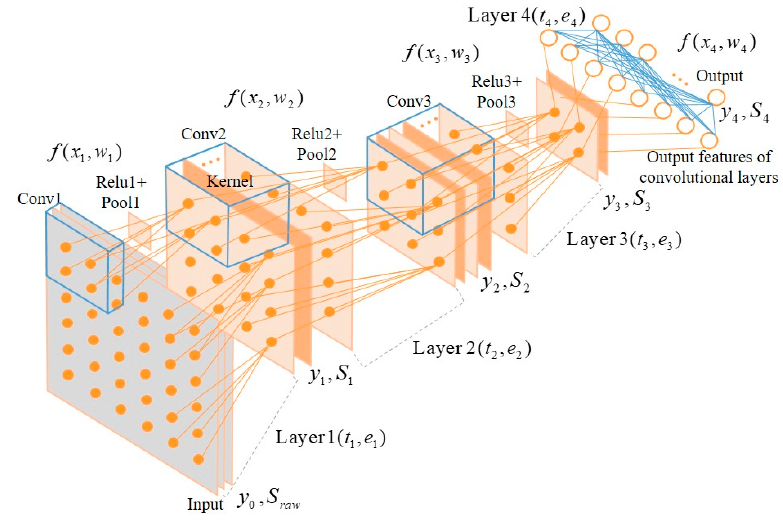
Figure 2. Applied deep learning structure (i.e., convolutional neural network). Blue cubes and solid lines present the learnable parameters.